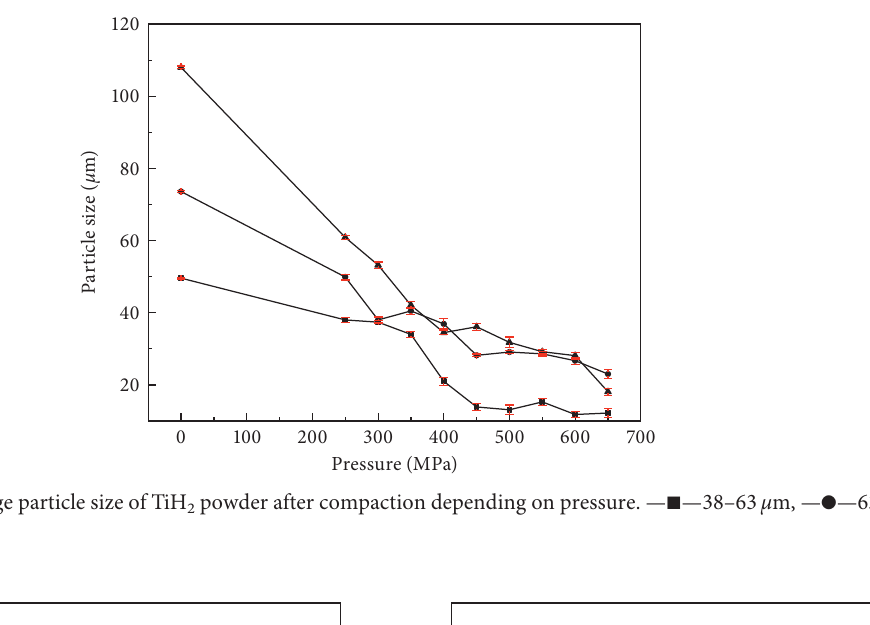
Figure 6: The influence of different compaction pressures on PSD of initial TiH (c) 88–125 μ m TiH 2 . — ■ —initial powder, — ● —powder after compaction (300 MPa), — ▲ —powder after compaction (450 MPa), and — ◆ —powder after compaction (600 MPa).